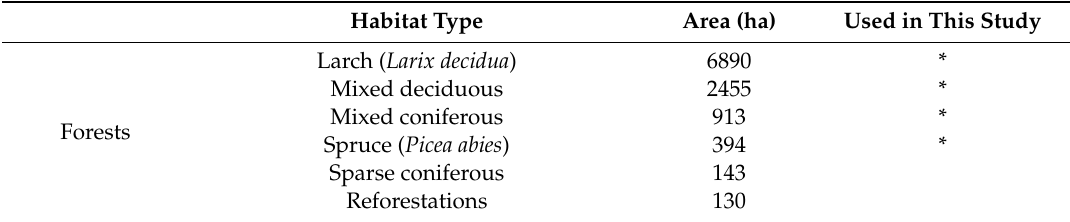
Table 1. Extension of habitat typologies of forests and grasslands in the